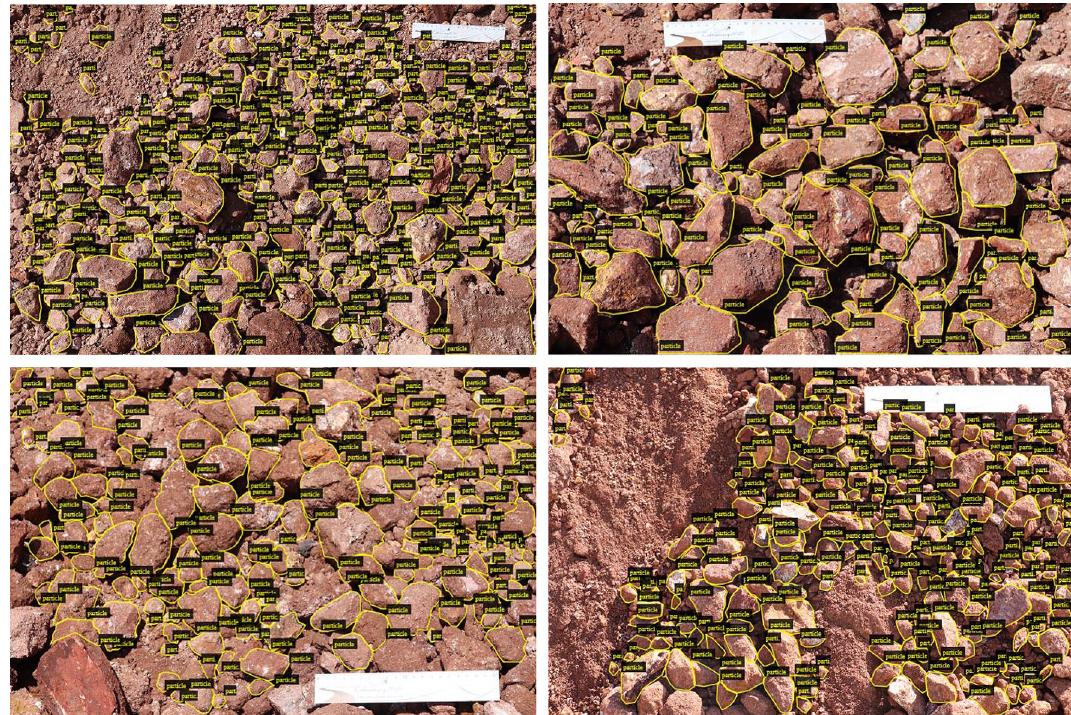
Figure 2. Some examples of annotated and labelled images for training